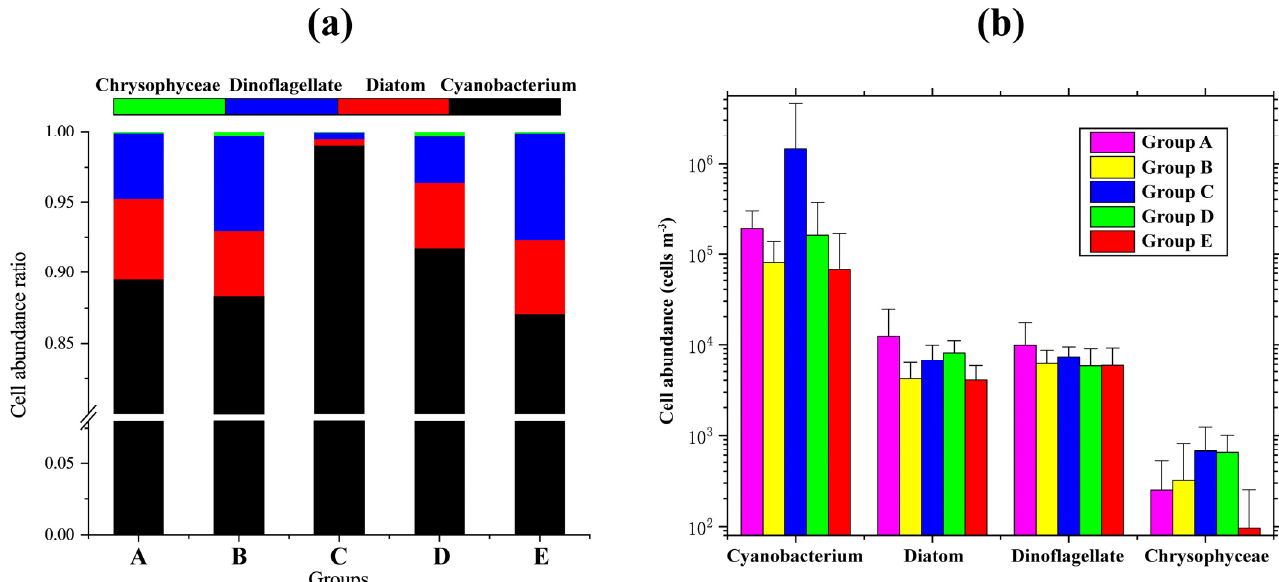
Figure 5. Species composition and changes between groups of phytoplankton in the WPO. ( a ) The cell abundance ratio of the four-phyla phytoplankton in each group; ( b ) The cell abundance (cells m − 3 ) of the four-phyla phytoplankton in each group.